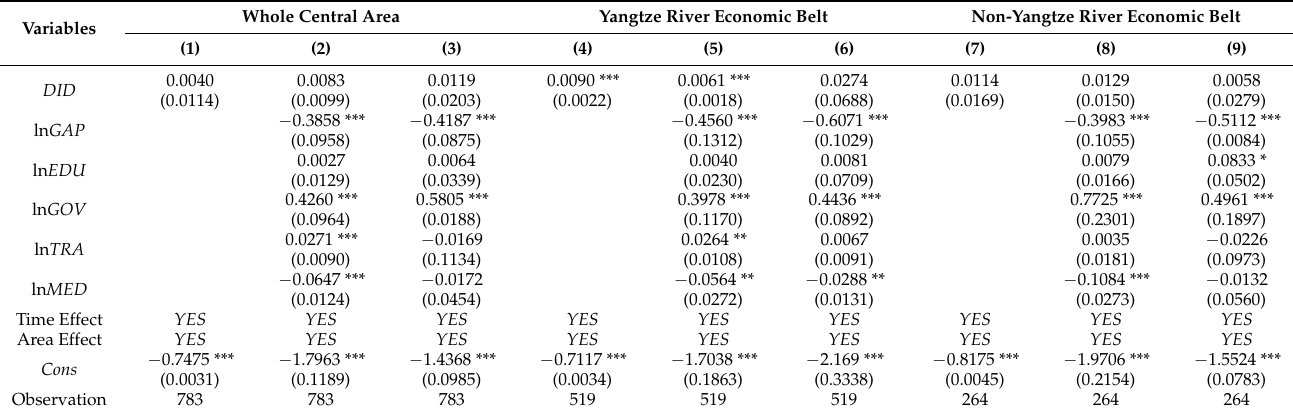
Table 4. Results of policy tests in central